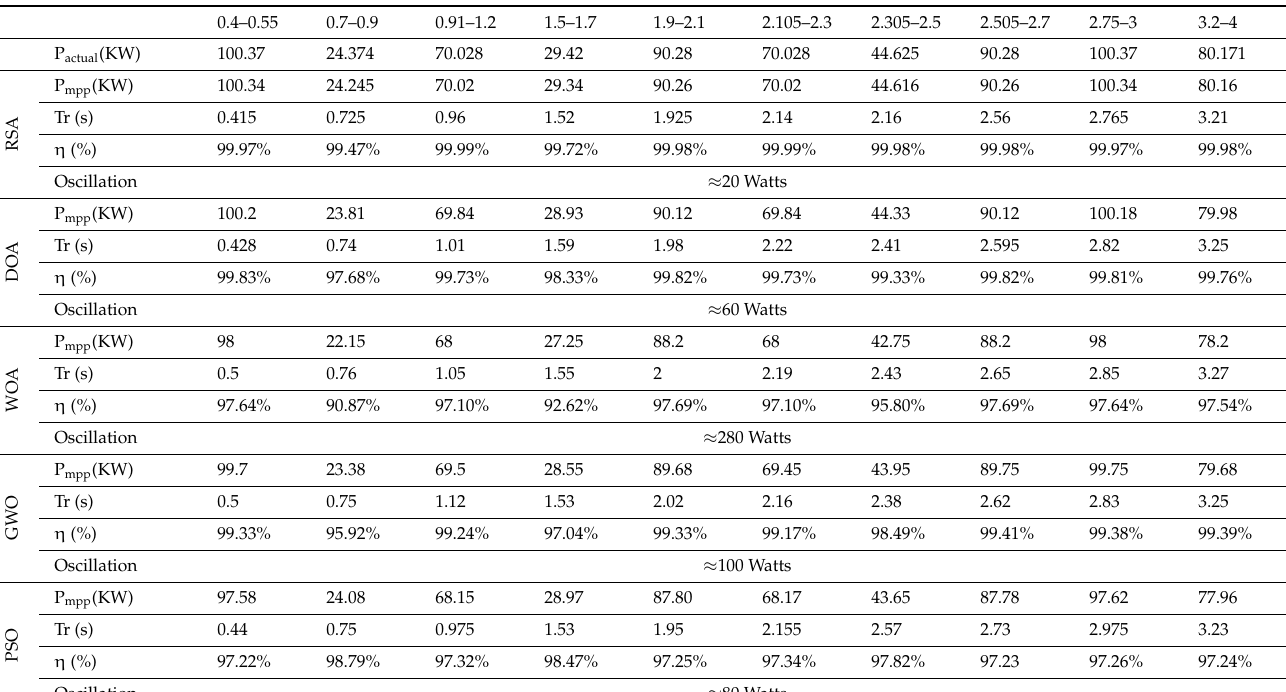
Table 2. Comparison of USI simulation results.